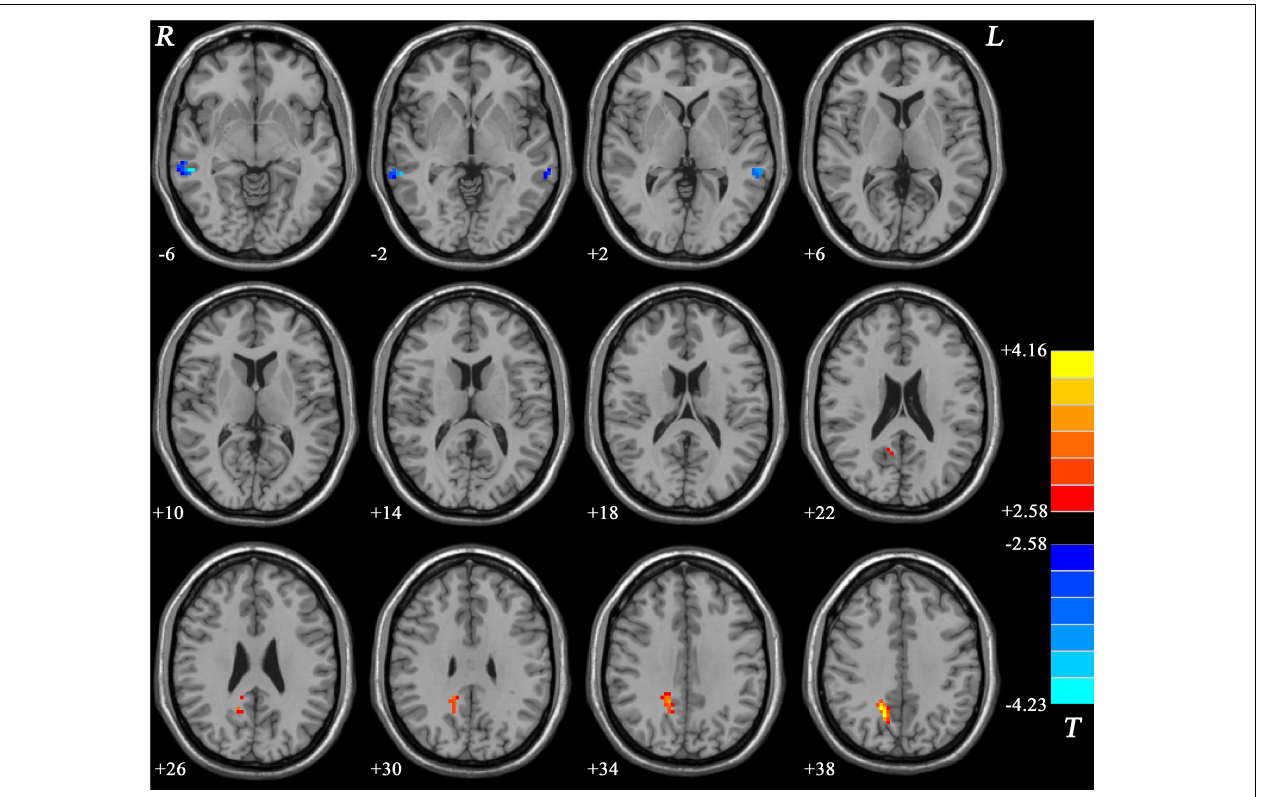
FIGURE 2 | Statistical map depicts higher and lower NH of MDD patients with GI symptoms compared with MDD patients without GI symptoms. The threshold was set at p < 0.05. Blue denotes lower NH, and red denotes higher NH. Color bar indicates T values from the two-sample t -test. NH, network homogeneity; GI, gastrointestinal